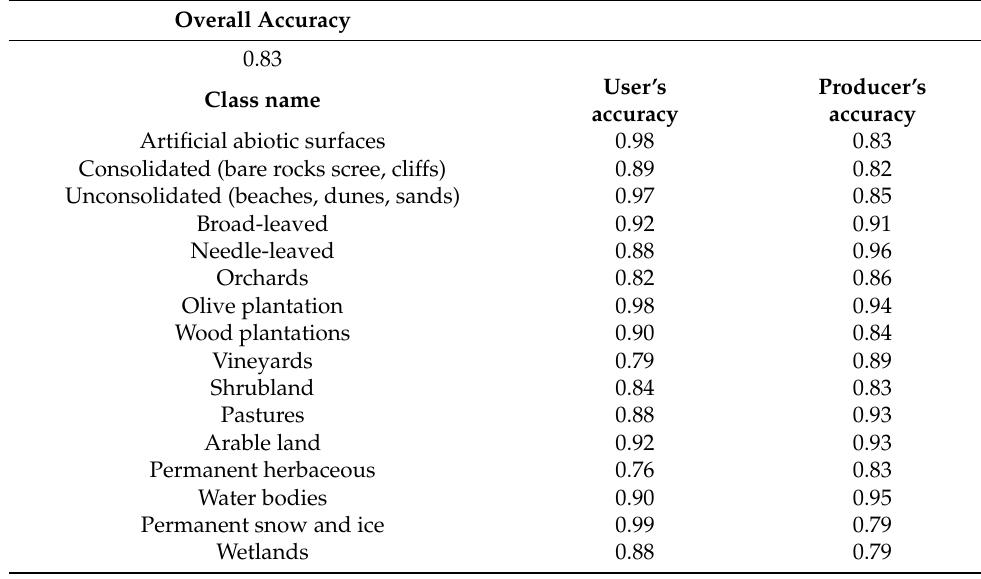
Table 10. Overall, user and producer accuracy of the 2012 land cover